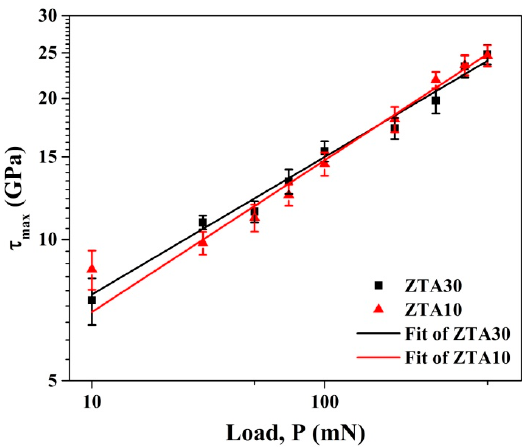
Figure 3. Maximum shear stress ( τ max ) variation underneath the nanoindentation tip with applied peak load.